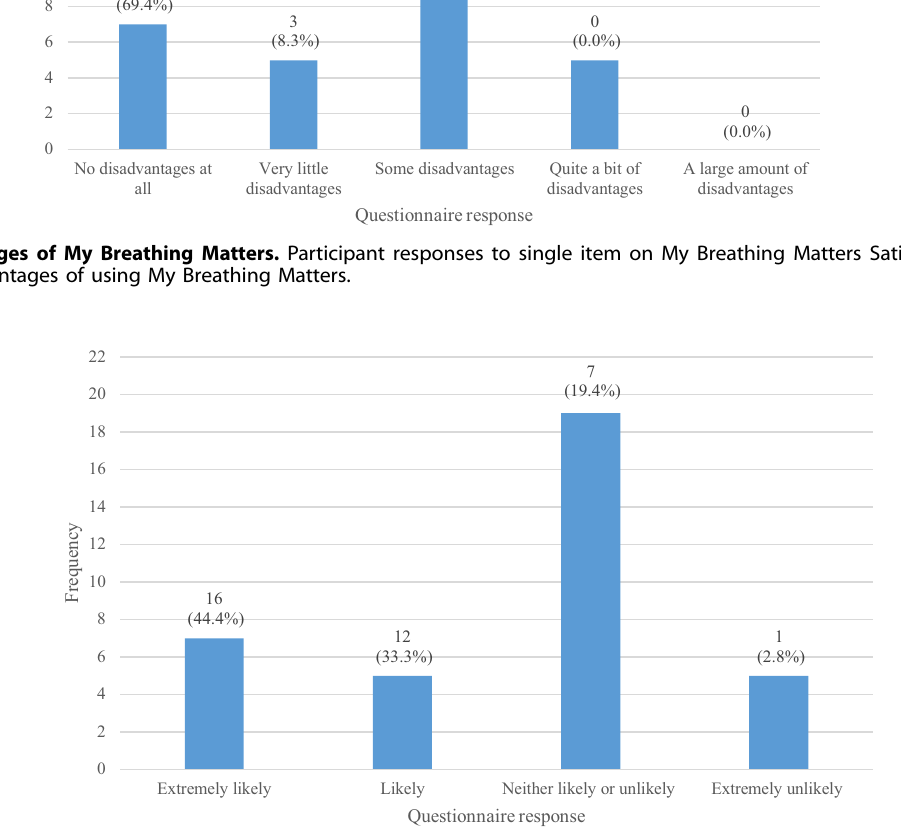
Fig. 3 NHS Friends and Family Test. Participant responses to NHS friends and family test relating to how likely they would be to recommend My Breathing Matters to friends and family if they needed similar care and